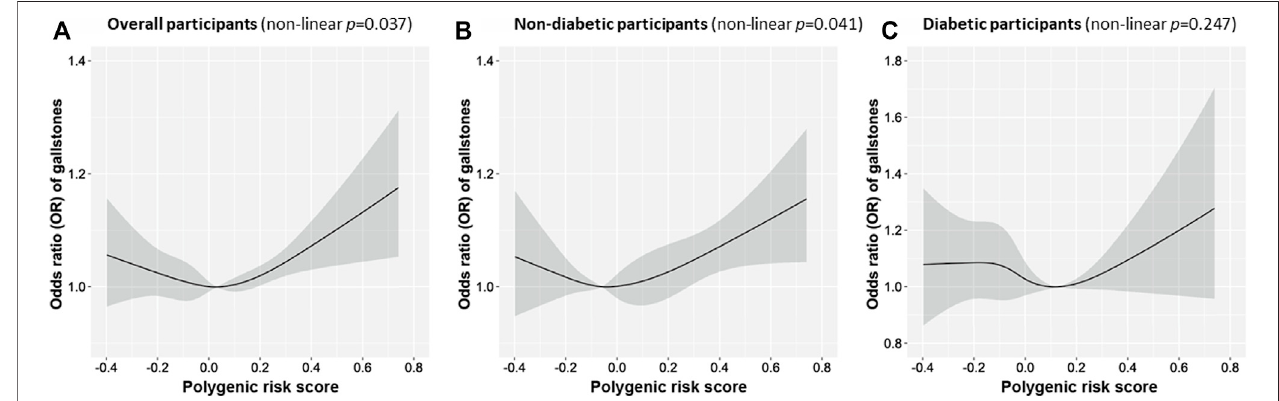
FIGURE 3 | Nonlinear regression of association between the polygenic risk scores of growth differentiation factor 15 and gallstones in overall participants (A) , nondiabetic participants (B) and diabetic participants (C) . Associations were adjusted for a comprehensive list of covariates, including age, sex, BMI and the fi rst 20 genetic principal components, deprivation index, smoking, drinking, physical activity, blood LDL-c levels, blood glucose levels, blood HbA1c levels, and metformin